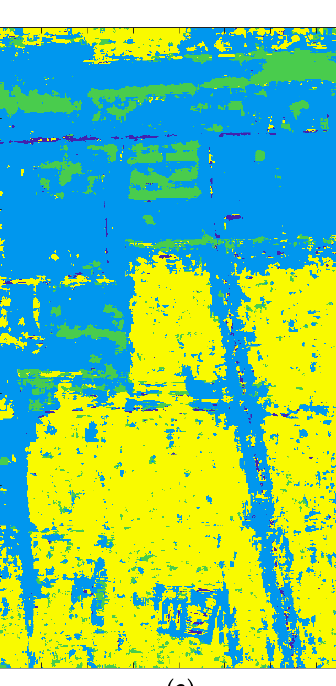
Figure 14. ( a ) C-band SAR classification results. ( b ) L-band SAR classification results. ( c ) P-band SAR classification results. ( d ) X-band SAR classification results.